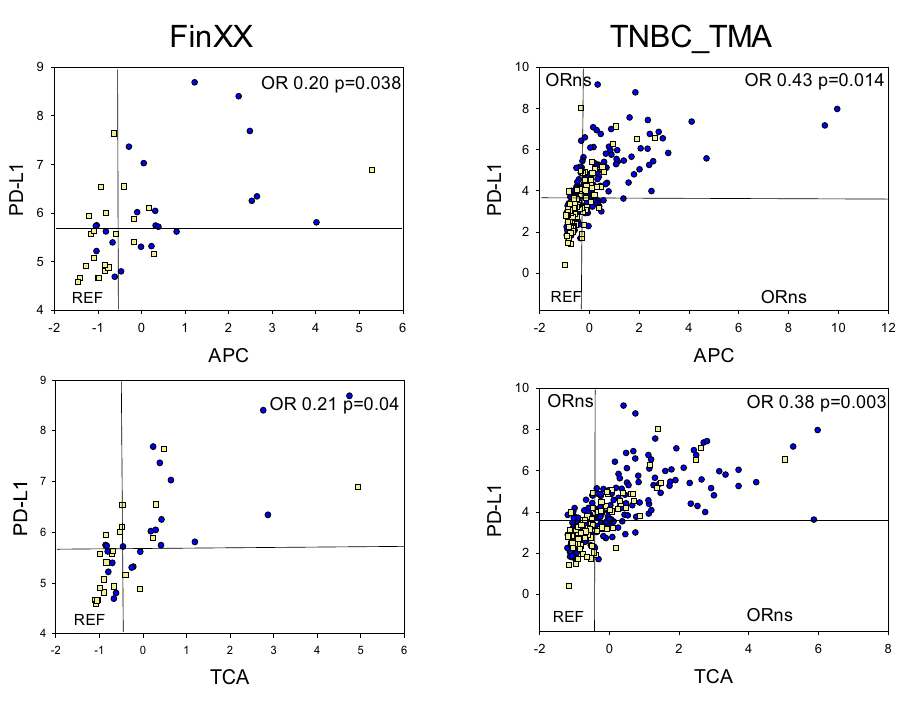
Fig. 16 (FinXX: log-rank p =0.002 and TNBC TMA: log-rank p =0.02 for APChigh/TCAhigh vs. APClow/TCAlow). Odds ratios for 5-year recur-